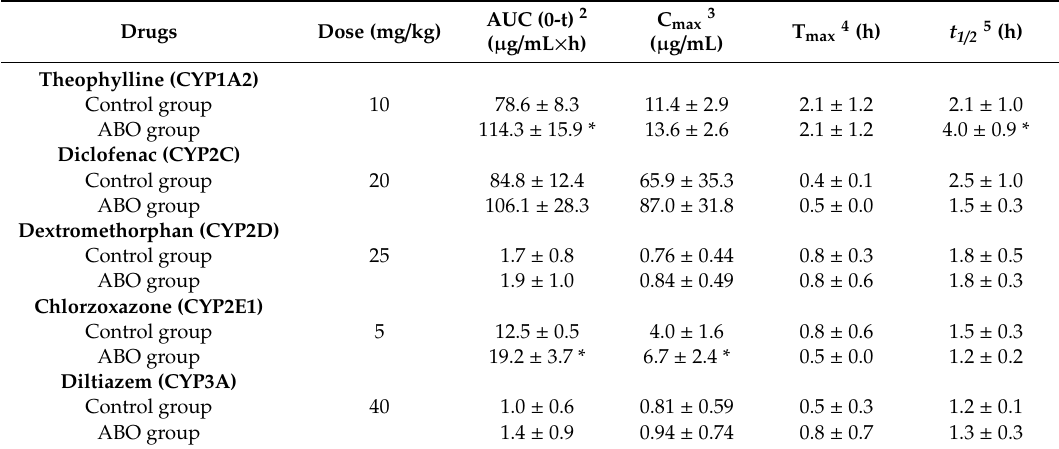
Table 3. Pharmacokinetic parameters of five drugs (PO dosing) after feeding with the ABO-containing diet for 7 days in rats 1